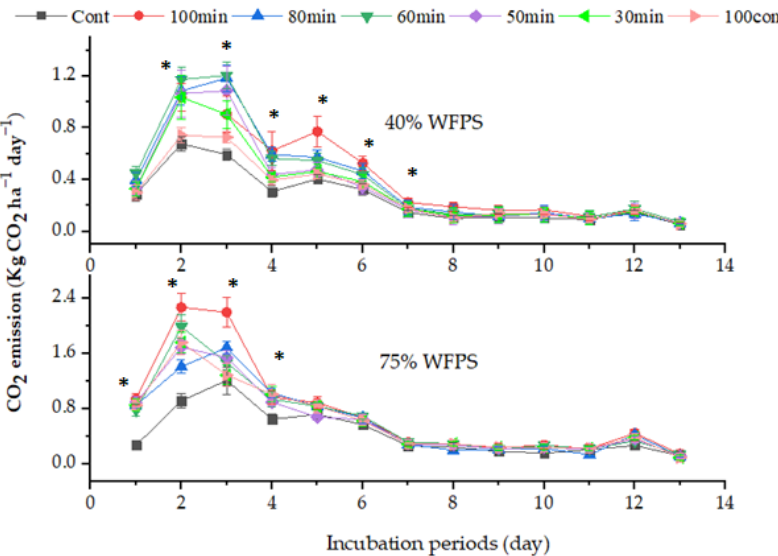
Figure 4. Emissions of carbon dioxide (CO 2 -C) from treatments with different fertilizer types and water-filled pore space (WFPS) (40 and 75%). Cont.: Control (no input); 100 min: 100% mineral fer- tilizer N (100 kg N ha − 1 ) and P (33.3 kg P ha − 1 ), 80 min: 80% mineral fertilizer + 1.4 t ha − 1 compost; 60 min: 60% mineral fertilizer + 2.8 t ha − 1 compost; 50 min: 50% mineral fertilizer + 3.5 t ha − 1 compost; 30 min: 30% mineral fertilizer + 4.9 t ha − 1 compost, and 100comp: 100% compost (7 t ha − 1 compost). * indicates significant differences among the treatments (Tukey HSD test, p< 0.05). Error bars indicate the standard error of the mean (n = 3). The CH 4 emissions were highest on days two and three (Figure 5). No differences were found between the treatments.